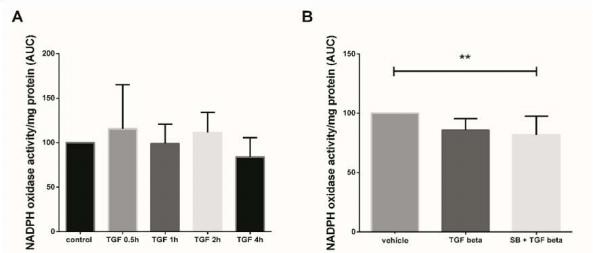
Figure 1. Effects of transforming growth factor 1 (TGF- β 1) treatment on NADPH oxidase (Nox) activity. ( A ) Kinetics of Nox activity in first trimester chorionic villi exposed to 10 ng/mL TGF- β 1. Superoxide production was monitored for 30 min. Results are expressed as area under curve and normalized on protein levels. Data are represented as median +/ − interquartile range, n = 5 different placentas. Friedman test was applied; ( B ) Chorionic villi were treated with TGF- β 1 (10 ng/mL) for 48 h with or without pretreatment with SB203580 (10 µ M) for 1 h. Treatment with p38 MAPK inhibitor significantly decreases Nox activity. Data are represented as area under curve normalized on protein levels and expressed as a percentage of the vehicle group. Mean +/ − SEM, ** p < 0.01, n = 13 different placentas. Friedman test was applied. Control refers to untreated chorionic villi and vehicle refers to DMSO treatment.